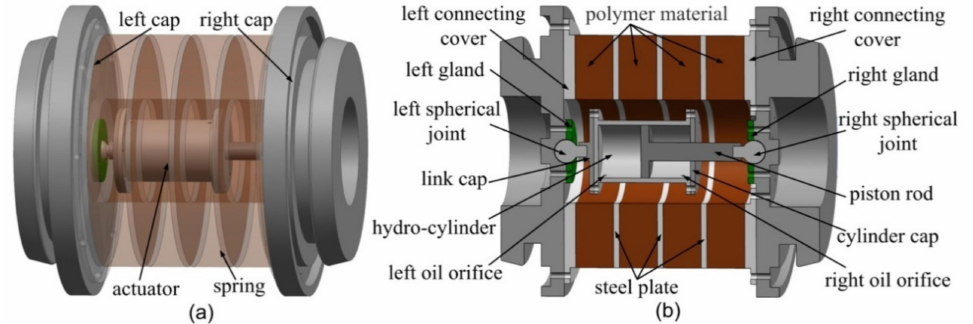
Figure 2. ( a ) Sketches of the actuator-based flexible connector model; ( b ) the cross-sectional view of the novel connector.